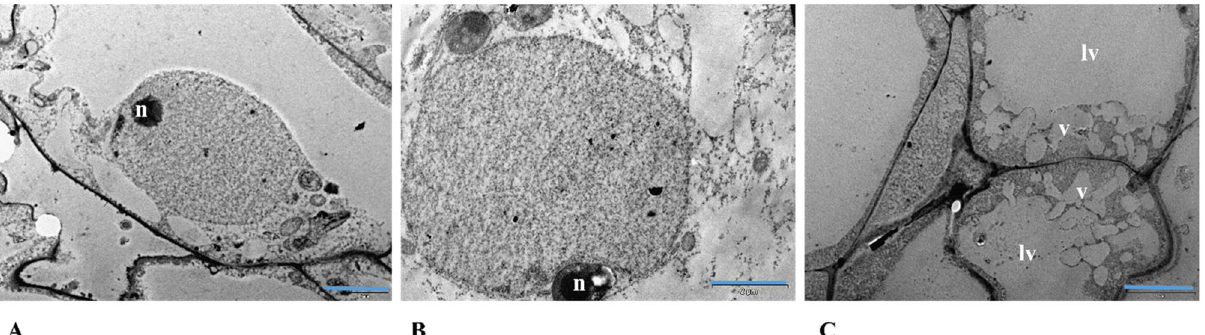
Figure 3. Electron micrographs of zygotic and somatic embryo cells. ( A ) Zygotic, ( B ) normal somatic and ( C ) abnormal somatic cell. Different from zygotic and normal somatic cell, some cells from abnormal SE had a higher number of vesicles, large lytic vacuoles and the nonexsistence of the nucleus. n nucleus, lv lytic vacuole, v vesicles. Scale bar, 2 µm (zygotic and abnormal somatic cells ( A,C )); 5 µm (normal somatic cell ( B of normal SE were not stained in red fluorescence, showing no cellular death, but the same region in abnormal SE showed a fluorescence intensity of 2.E + 04 arb. units (Fig. 4I). Whole‑genome DNA methylation maps of zygotic and somatic embryos. Unbiased DNA meth- ylation maps were generated from a set of mixed embryos samples from ZE, normal and abnormal SE by WGBS. We sequenced a total of 57.2 Gb from ZE, 74.1 Gb from normal SE and 72.5 Gb from abnormal SE. The accession number for the three WGBS is PRJNA857502 in the National Center for Biotechnology Information (NCBI), https:// www. ncbi. nlm. nih. gov/ sra/ PRJNA 857502. From the total base pairs, we mapped from each sample 86.14%, 67.08% and 68.30% of sites with methylation in ZE, normal and abnormal SE, respectively, with Phred quality score over 30, where the CpG content in percent (%) is 21.04%, 24.88% and 24.3% in each sample, respec- tively (Supplementary Table S1). After trimming process to eliminate adapter sequences and bases with low quality from each read, we generated a total of 53.8 Gb (ZE), 57.1 Gb (normal SE) and 54.6 Gb (abnormal SE), which were aligned to the Cacao_Matina1-6 genome sequence used as reference genome. In the basic statistics of the alignment for ACGT content by chromosome, 86.58–104.03% were covered by at least one unambiguously mapped read with Phred quality score over 30 and standard deviation between 322.33 and 452.18, resulting in an overall average sequencing depth of 30-fold (Supplementary Table S2). For methylation calling we used a total read of 203,071,419 from ZE, 263,500,094 from normal SE and 245,099,294 from anormal SE (Supplementary Table S3). Methylation calling was different between the contexts. From the total sequencing coverage of CpG, CHG and CHH contexts across all the genome, only 50.14–53.95% (CpG), 28.23–31.58% (CHG) and 5.34–9.91% (CHH) were methylated. Normal SE showed the highest methyla- tion percentages over the three contexts. By contrast, ZE showed the lowest and abnormal SE the intermediate values (Supplementary Table S4). A total of 7,391,277 CpG, 10,706,841 CHG and 66,034,574 CHH methylation sites were identified in this study. For all the contexts (CpG, CHG, and CHH), the lower sequencing depth cut-off was10. 7,361,253 CpG, 10,679,910 CHG and 65,894,628 CHH methylation sites to be analyzed. In the CpG context we found a binomial distribution in the level of methylation for most of the data (Supplementary Fig. S2). ZE methylation landscape showed that 35.02% of the CpG were with DNA methylation levels between 0.0 and 0.1(low methylation values) and 35.82% were with values between 0.9 and 1.0 (high methylation values). For normal SE, 36.33% of the CpG sites were low methylated and 46.11% were high methylated. Finally, for abnormal SE 35.86% of CpG sites were low methylated and 43.43% were high methylated. These results show that normal and abnormal SE had a higher percentage of high levels of methylated CpG sites in comparison with ZE. The CHG and CHH contexts were analyzed as bimodal and right-skewed distribution, respectively (Sup- plementary Figs. S3, S4). The CHG context in ZE, normal and abnormal SE samples showed the maximum data as low methylated, with values between 0.0 and 0.1, and with frequencies of 60.11%, 60.15% and 60.08% respectively. CHH context analysis showed methylation levels between 0.0 and 0.1 in ZE, normal and abnormal SE, with frequencies of 82.42%, 71.85% and 74.65%, respectively. The degree of reproducibility between samples, the normal distribution between samples and the density plot to compare distribution of methylation ratio before and after normalization were analyzed using Pearson’s correlation (Range: − 1 ≤ r ≤ 1), box plot and density plot, respectively (Supplementary Figs. S5A–C, S6A–C, S7A–C). DNA methylation dynamics in non‑CpG and CpG contexts.